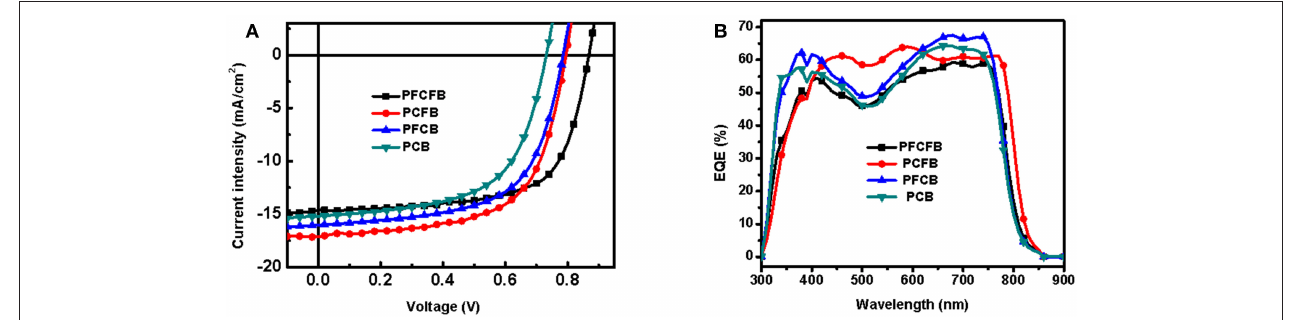
FIGURE 3 | J-V (A) and EQE (B) curves of OSCs based on PFCFB, PCFB, PFCB, and PCB .